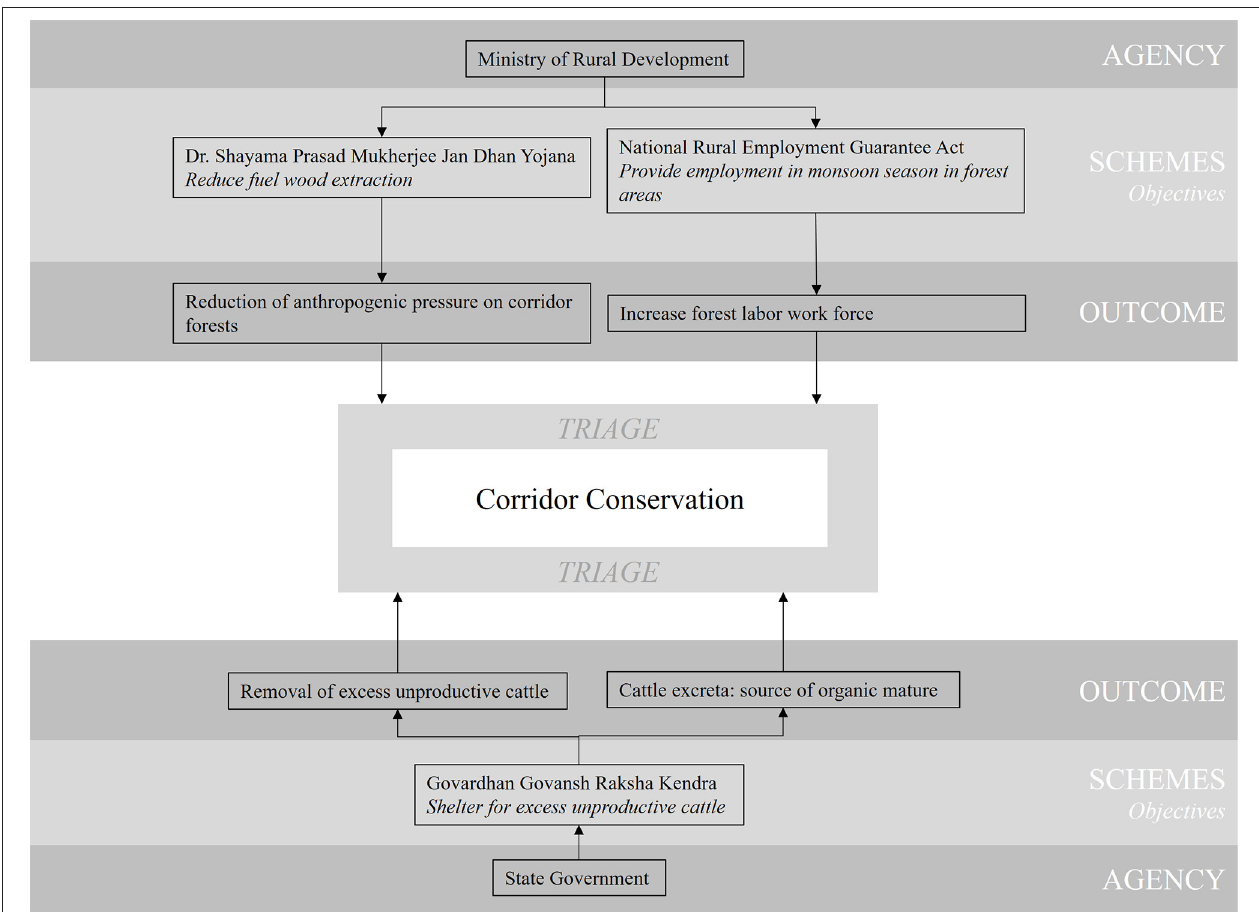
FIGURE 1 | The figure is showing various tasks which can be carried out by the agencies from other Ministries of Govt. of India where conservation is not the goal (triage of